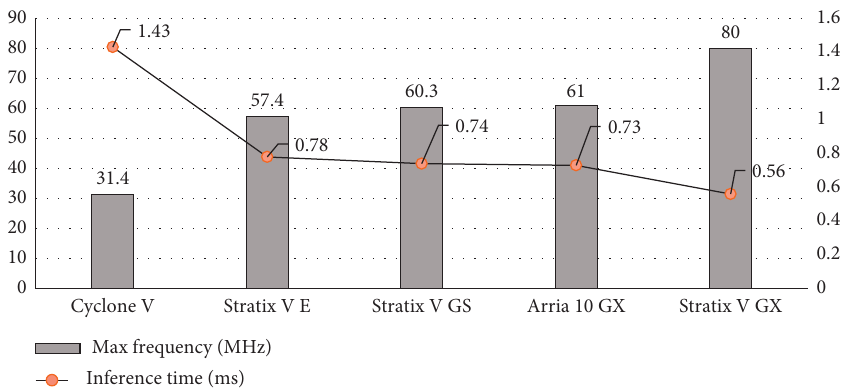
Figure 9: Maximum clock frequency and inference time for different Intel FPGA